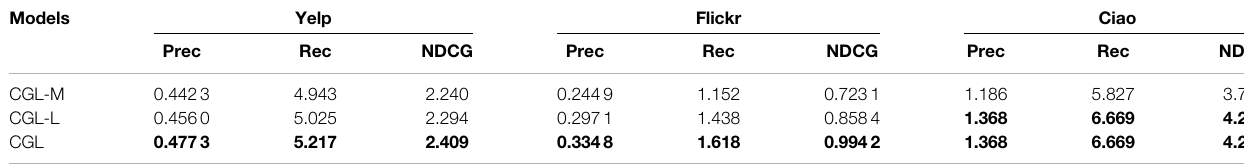
TABLE 7 | Comparison of CGL and its variants with different readout strategies ( K = 20). The best results are in bold. Models